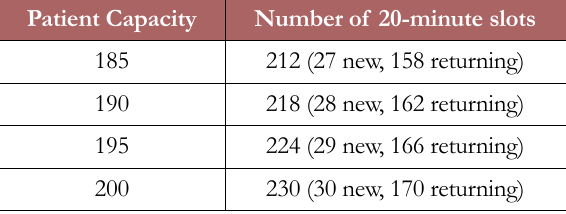
Table 6. Evaluated patient capacity